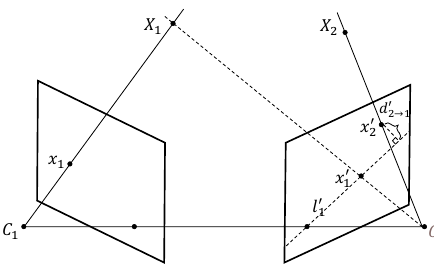
Figure 2. Illustration for epipolar